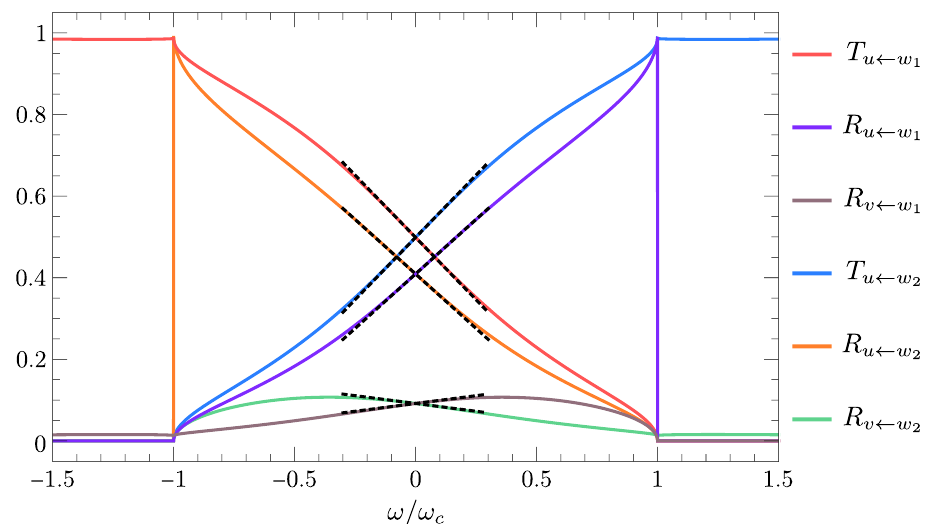
Figure 4: Transmission and reflection probabilities for an incoming mode incident on the sharp horizon from the black hole (type II) region for ( V lines correspond to the first-order analytical results given in Eqs. (68) and